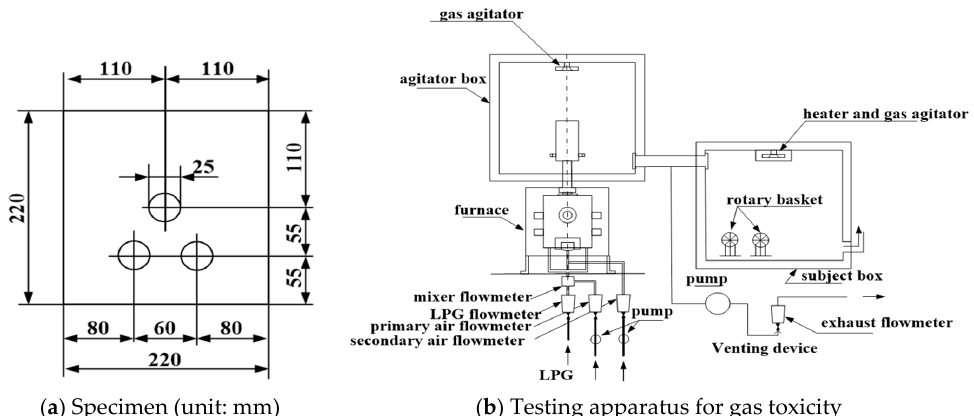
Figure 1. Configuration of testing specimen and apparatus for gas toxicity.